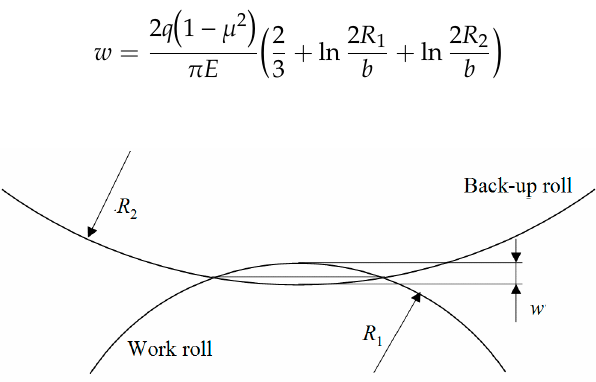
Figure 5. Schematic diagram of contact flattening between the back-up roll and the work roll.